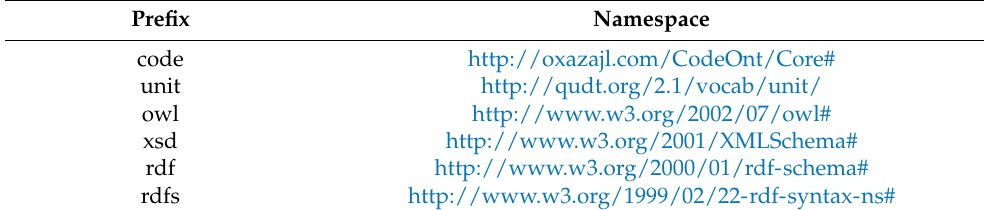
Figure 1. Multiscale modelling framework for building codes. Table 1. Namespaces and related prefixes used in this paper.